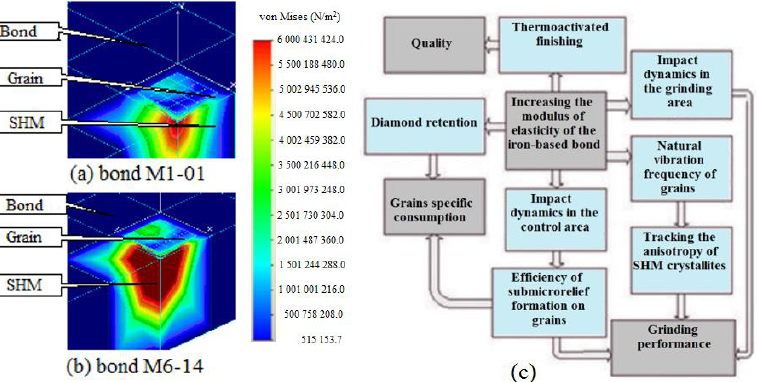
Figure 3. Influence of the elastic modulus of the bond on the efficiency of diamond grinding SHM: ( a ) reduced stresses in the “grain-SHM” system for the M1-01 bond ( E = 72 GPa), ( b ) reduced stresses in the “grain-SHM” system for the M6-14 bond ( E = 196 GPa), ( c ) algorithm for the influence of the elastic modulus of the bond on the efficiency of diamond grinding.